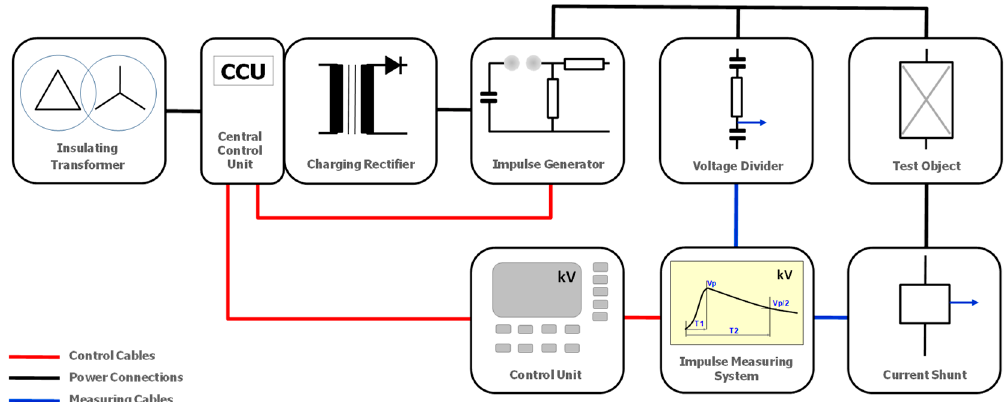
Figure 3. HVEP test rig block diagram.